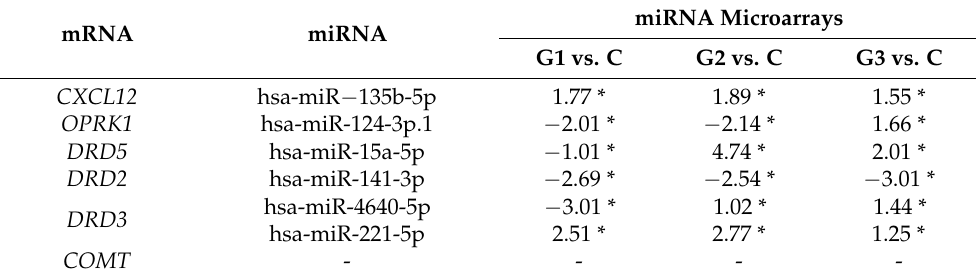
Table 3. List of dopamine-related genes, whole activity may be regulated by miRNAs in endometrial cancer, determined with microarrays and TargetScan ( p <